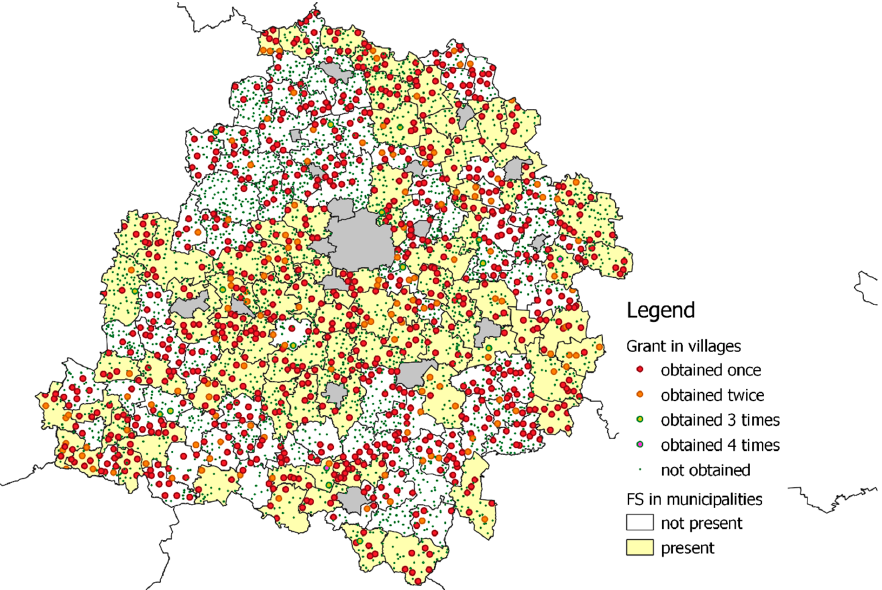
Figure 1. Territorial distribution of beneficiaries of the programme in the years 2016–2020 in the region, including the occurrence of a So ł ecki Fund (2019). Table 3. Number of municipalities with consideration of the number of grants in a given year.